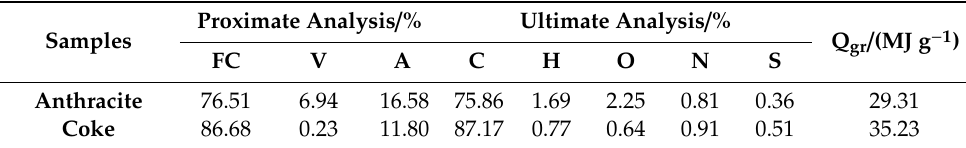
Table 1. Proximate and ultimate analysis of the fuel (in dry